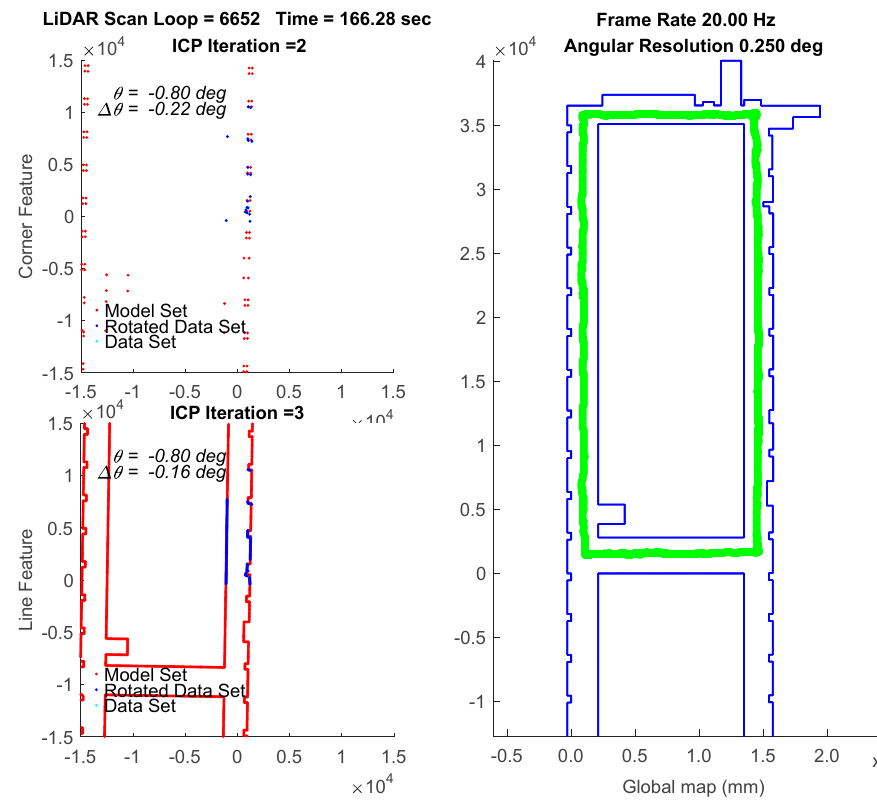
Figure 15. Localization by the WP-ICP with 10 cm interpolation. Upper left corner subplot: corner features. Lower left corner subplot: line features. Right subplot: layout and estimated robot trajectory.